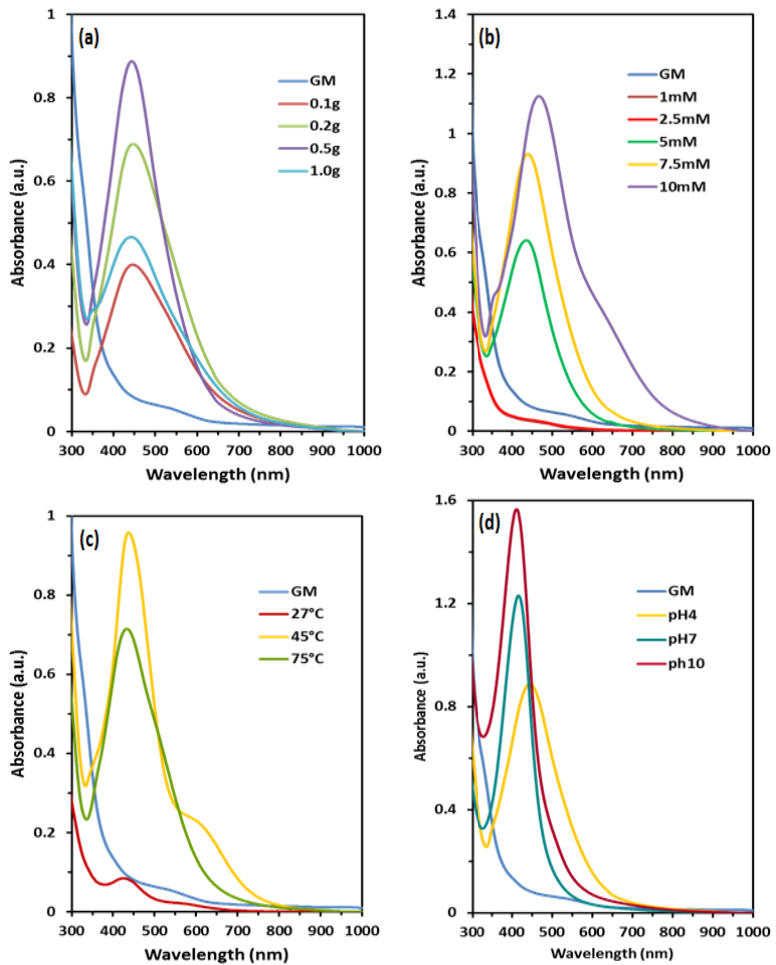
Figure 2. UV-visible spectra of AgNPs synthesized with various parameters: ( a ) amount of peels powder, ( b ) concentration of AgNO 3 , ( c ) temperature and ( d ) pH.